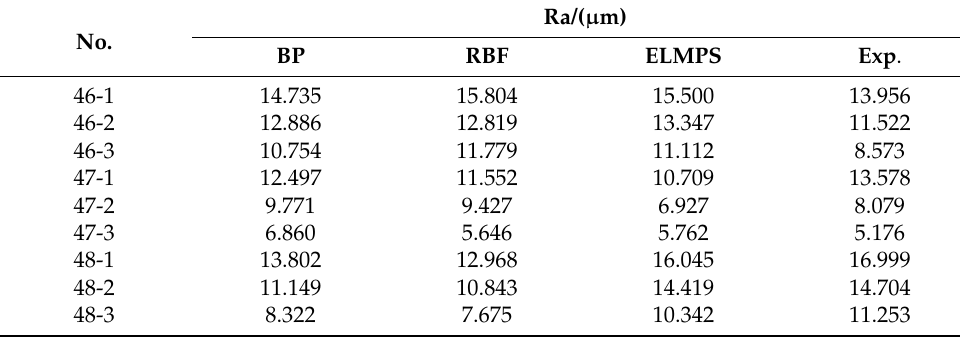
Table 6. Measured values and prediction results of